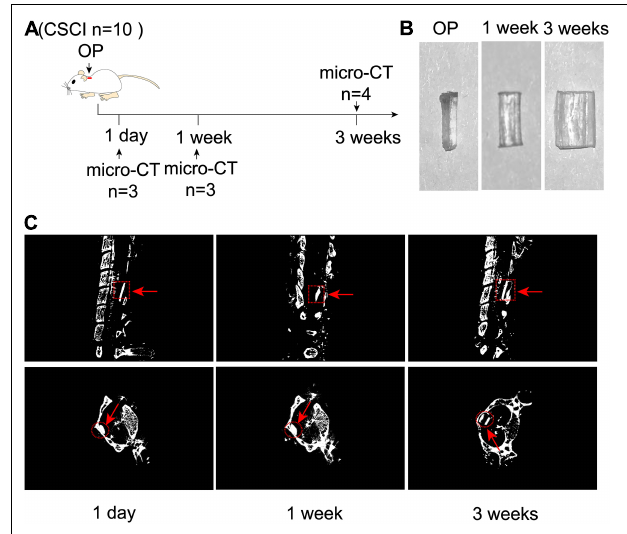
FIGURE 1 | Expansion of compression material after implantation. (A) Experimental design. (B) Alteration in the water-absorbable polyurethane polymer before and after surgery at 1 and 3 weeks. (C) Three-dimensional reconstruction and representative sagittal and transverse micro-CT images of the compressive segment. The red arrow indicates the compression site and material. 1 day post-injury: n = 3; 1 week post-injury: n = 3; 3 weeks post-injury: n =